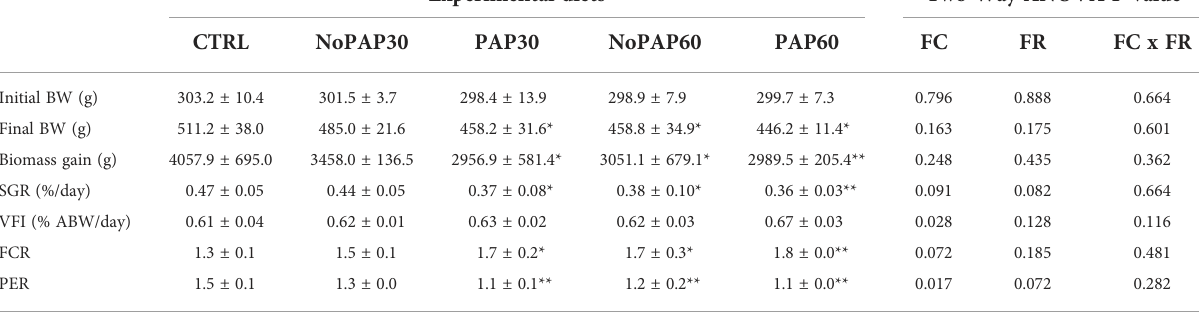
TABLE 3 Performance parameters of turbot fed fi ve experimental diets